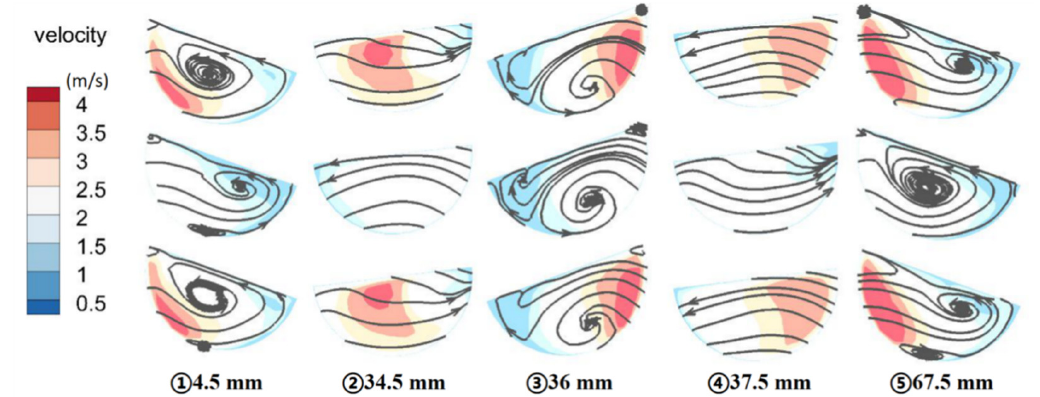
Figure 16. Variation of streamlines on sections at different distances from the cold fluid inlet (optimum structure: rotation angle θ = 20°).